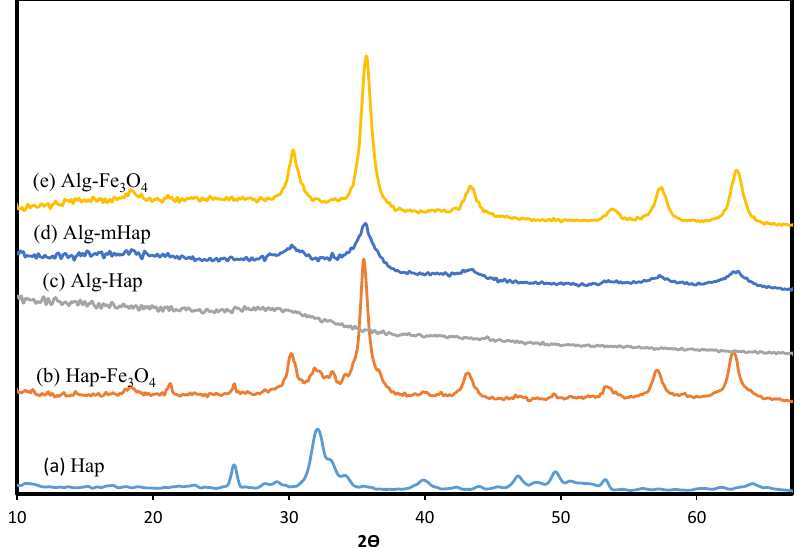
Fig. 3. X-ray diffraction of (a) Hap, (b) Hap-Fe